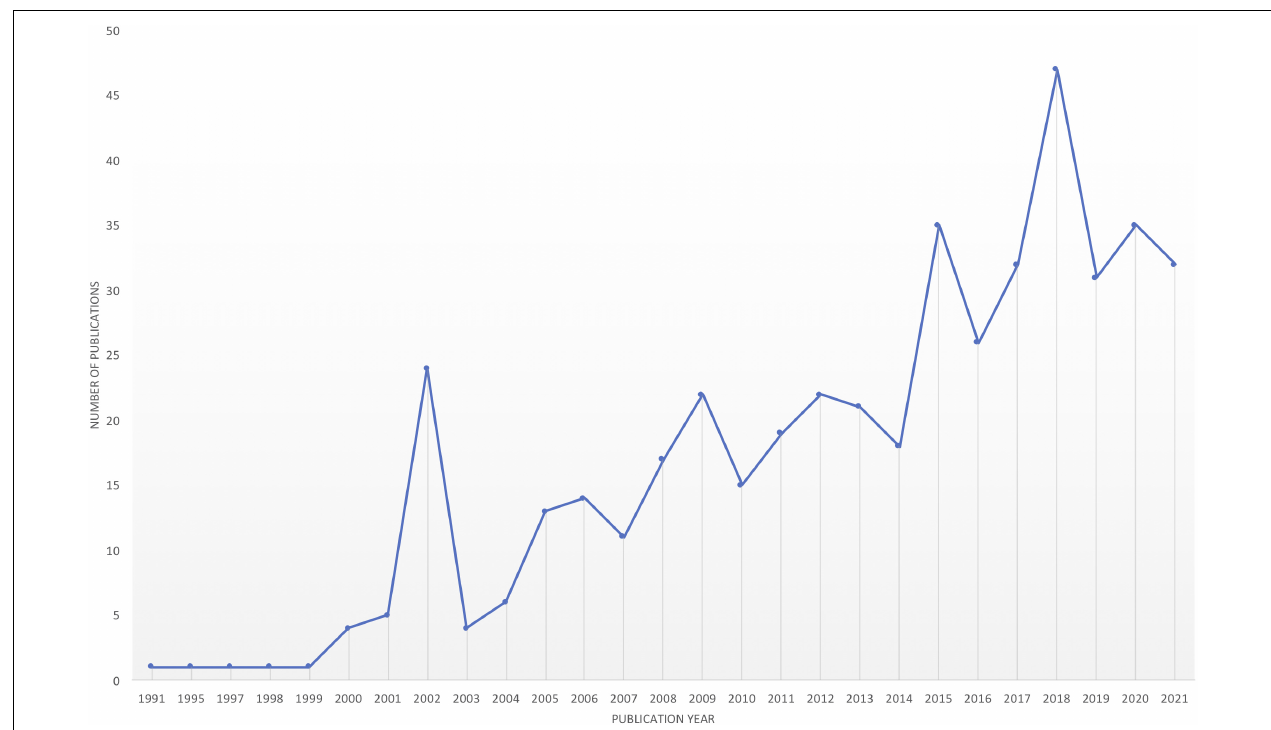
FIGURE 3 | Analysis of the type of research method (quantitative, mixed-methods, qualitative) utilized by